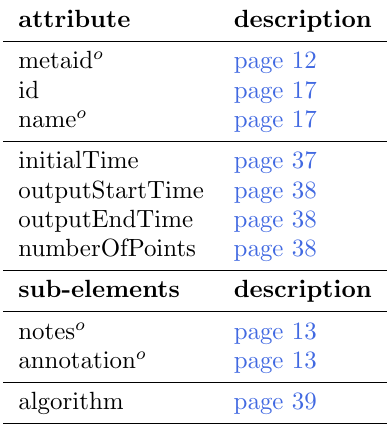
Table 2.14: Attributes and nested elements for uniformTimeCourse. o denotes optional elements and